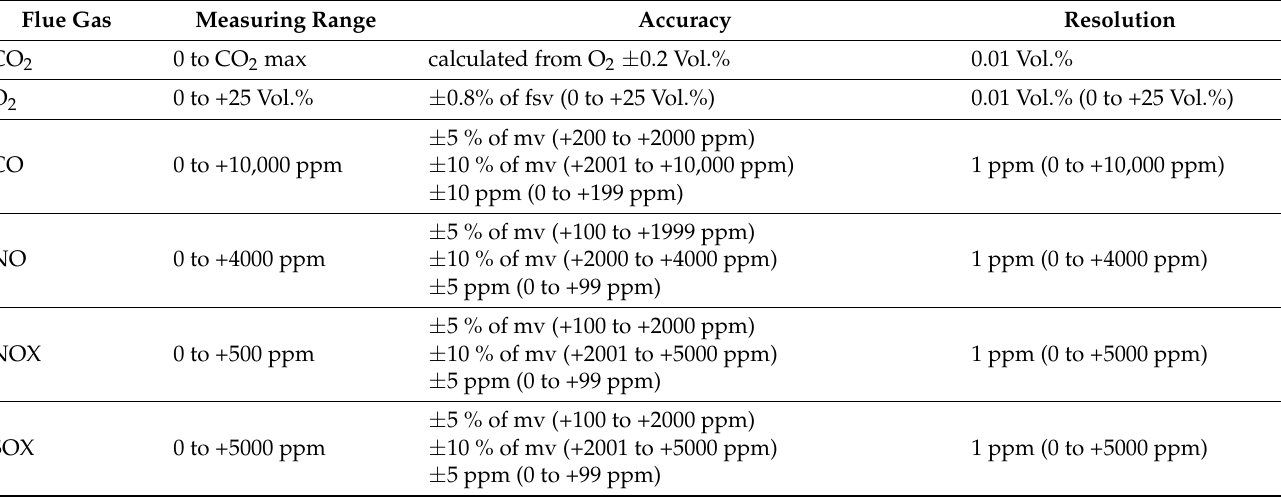
Table 5. Accuracy rates for industrial emission measurements with the Testo 350